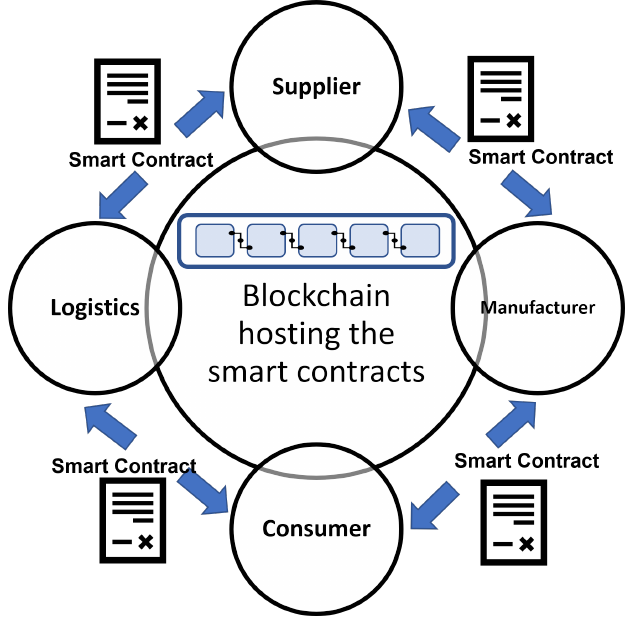
Figure 4. The use of smart contracts in logistics and supply